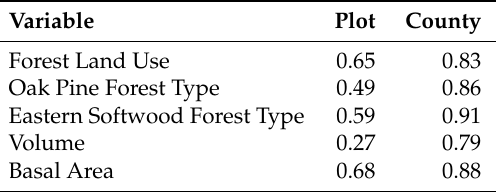
Figure 5. Ancillary and raking-estimated maps. Map size is 30 km × 10 km. From top to bottom: Probability of developed land use—ancillary; probability of developed land use—raking estimate; Forest Volume—ancillary; Forest Volume—raking estimate; Volume of Eastern Softwood—raking estimate. Table 4. Pearson correlation coefficient between the direct survey estimate and the regularized raking estimate. At the plot level, the direct survey estimate is the plot measurement (when multiple conditions are present, the direct estimate is the weighted average across conditions). At the county level, the direct survey estimate is the Horvitz–Thompson estimate from the plots in that